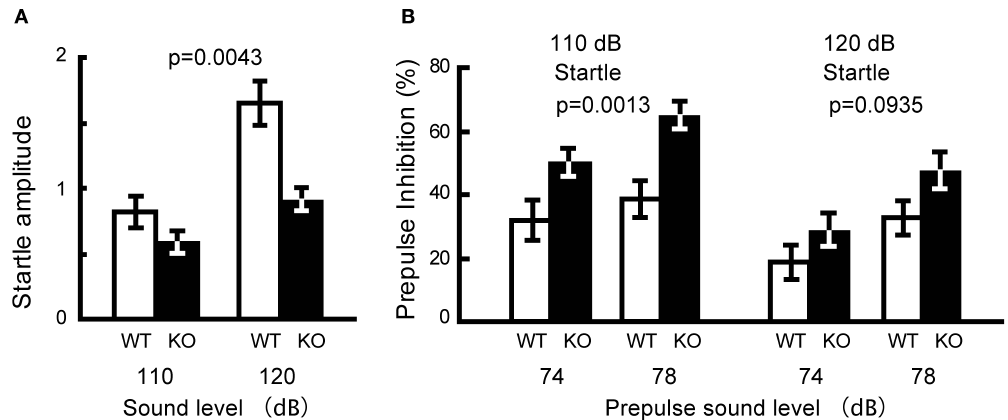
Figure 11 | Reduced startle amplitude and increased prepulse inhibition in kf-1 − / − mice. (A) Startle amplitude was signifi cantly reduced in ‘startle- stimulus -only’ trials ( p = 0.0043). (B) % Prepulse inhibition was signifi cantly increased in kf-1 − / − compared to that in kf-1 + / + mice (overall ANOVA including all four conditions, p = 0.0023). Data are given as mean ( ± SEM; see Section ‘Startle response/prepulse inhibition test’). WT and KO stand for kf-1 + / + and kf-1 − / − mice,